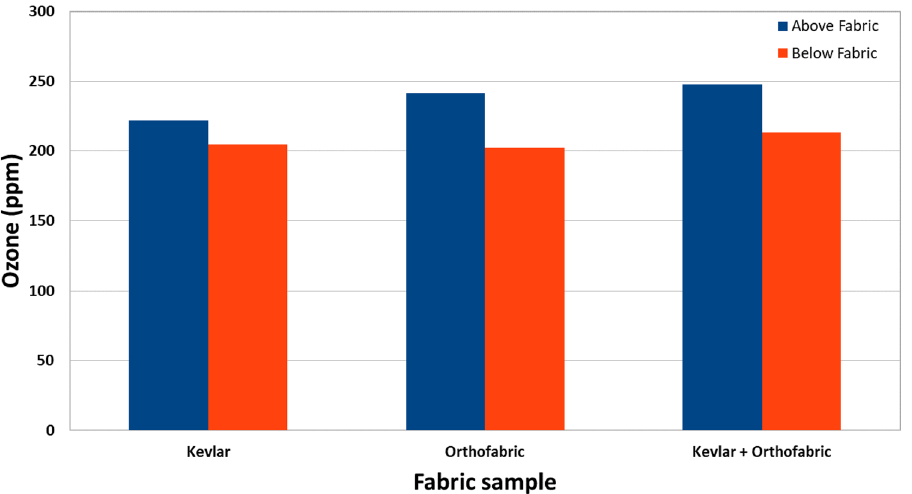
Figure 14. Ozone concentrations before and after fabric layers showing CPPR generated ozone penetration through fabric